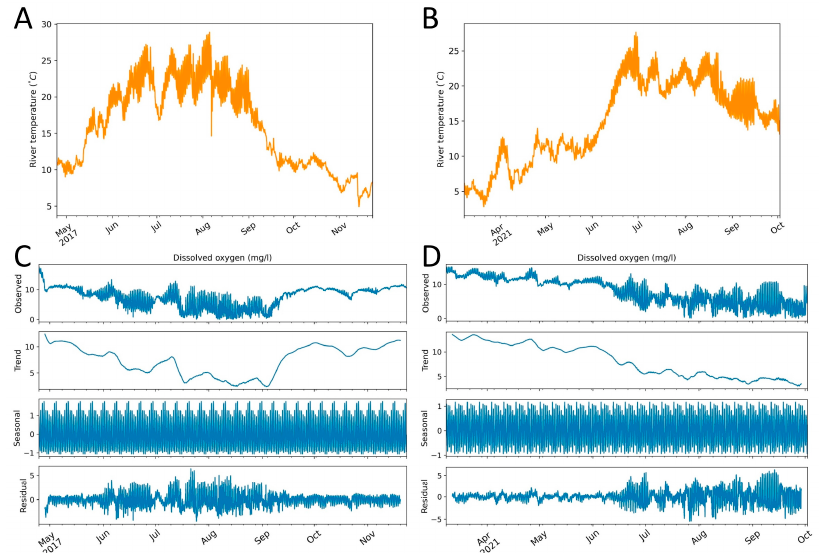
Figure 4. ( A , B ) River temperature and ( C , D ) DO in the river as measured (observed) and with additive time-series decomposition for variation of oxygen (trend, seasonal, residual) in 2017 and 2021, respectively. The measured data are assumed to be the sum of the trend, seasonality and residuals.